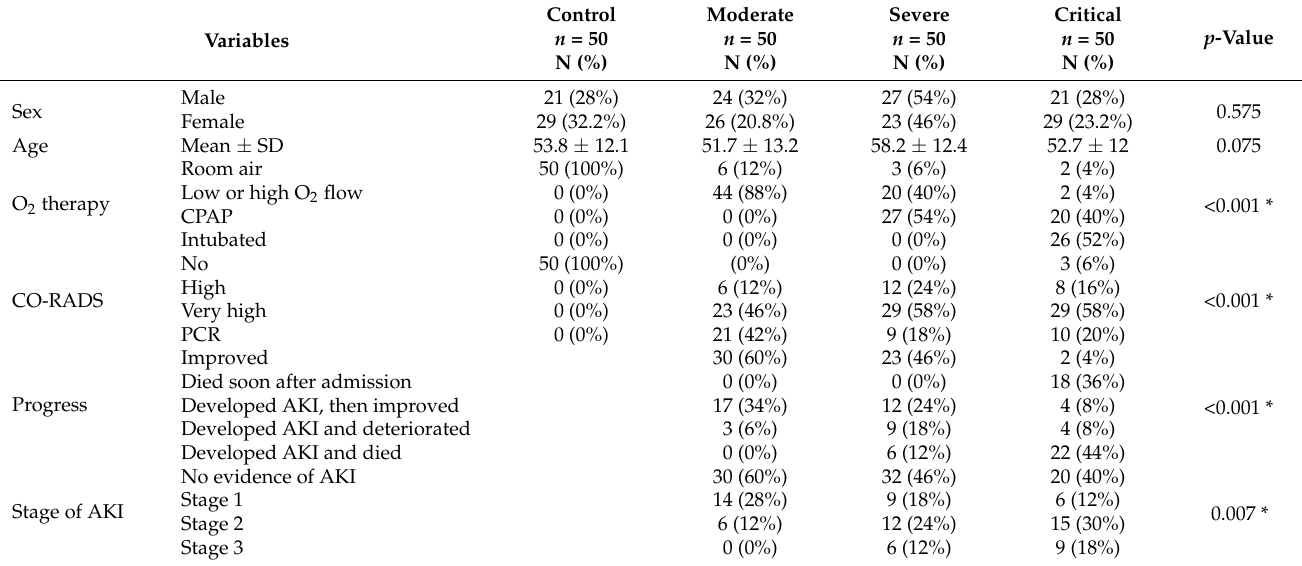
Table 1. Baseline clinical characteristics of studied COVID-19